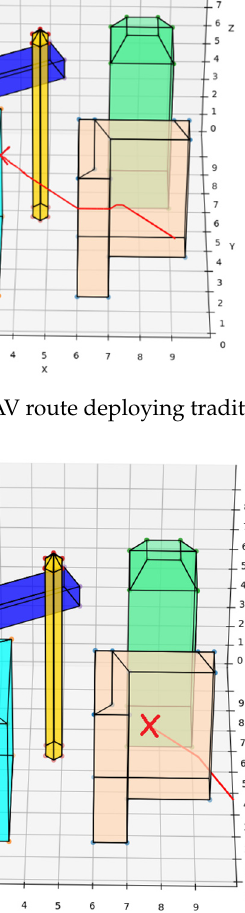
Figure 11. UAV route deploying traditional A* route planning algorithms in disturbance scenarios.